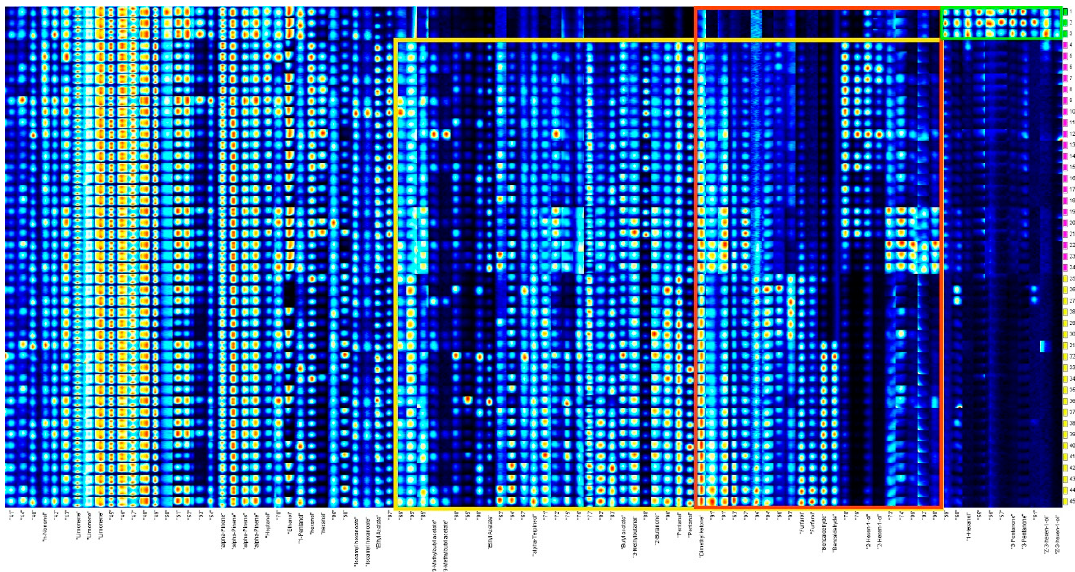
Figure 3. Fingerprints of all the samples generated using the Gallery Plot.